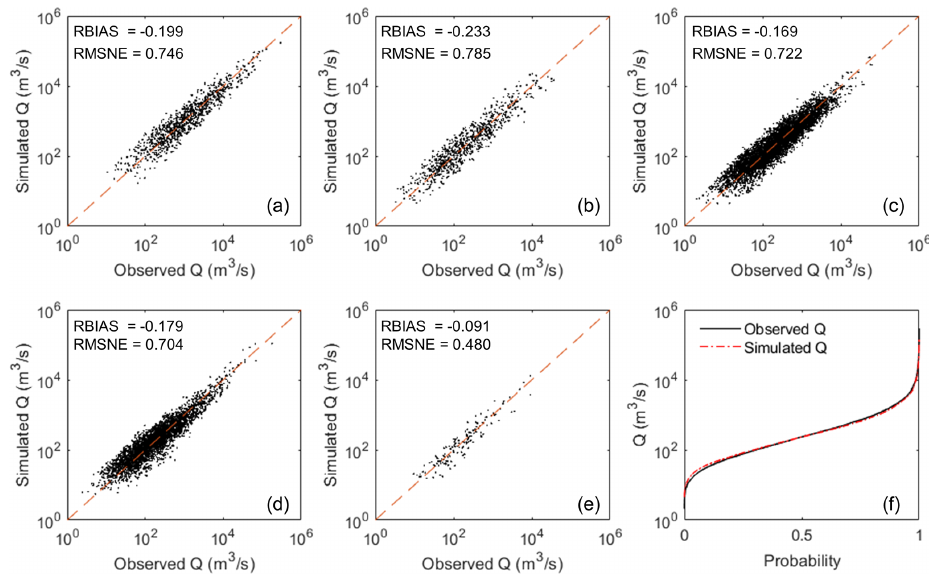
Figure 8. Results of simulated Q 100 in different climate zones, (a) tropical, (b) arid, (c) temperate, (d) cold and (e) polar. (f) Cumulative distribution function of simulated and observed discharge.